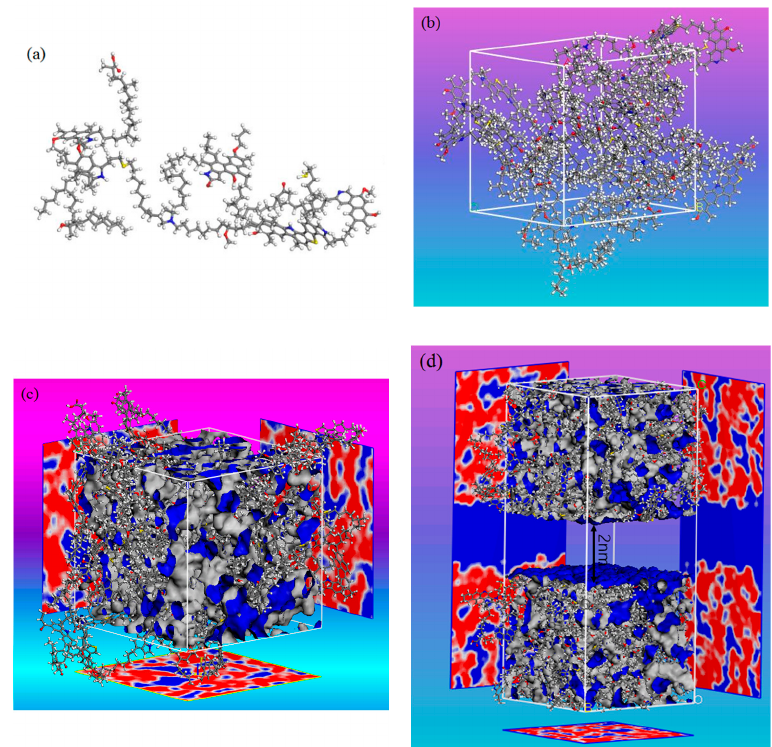
Figure 1. ( a ) Molecular model of type I-A kerogen molecule with a chemical formula C 251 H 385 O 13 N 7 S 3 ; ( b ) bulk kerogen configuration with 10 kerogen molecules; ( c ) bulk kerogen model with porosity; ( d ) structure of a realistic slit kerogen nanopore.